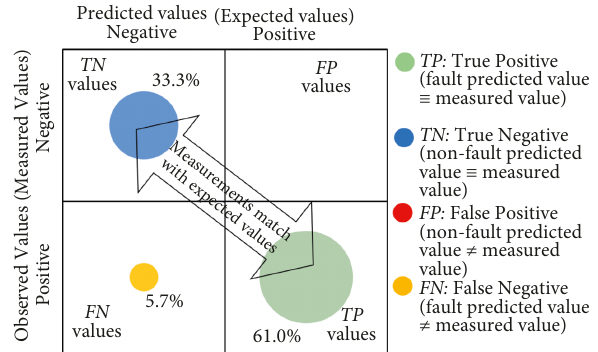
Figure 9: Confusion matrix for the PGFA admittance